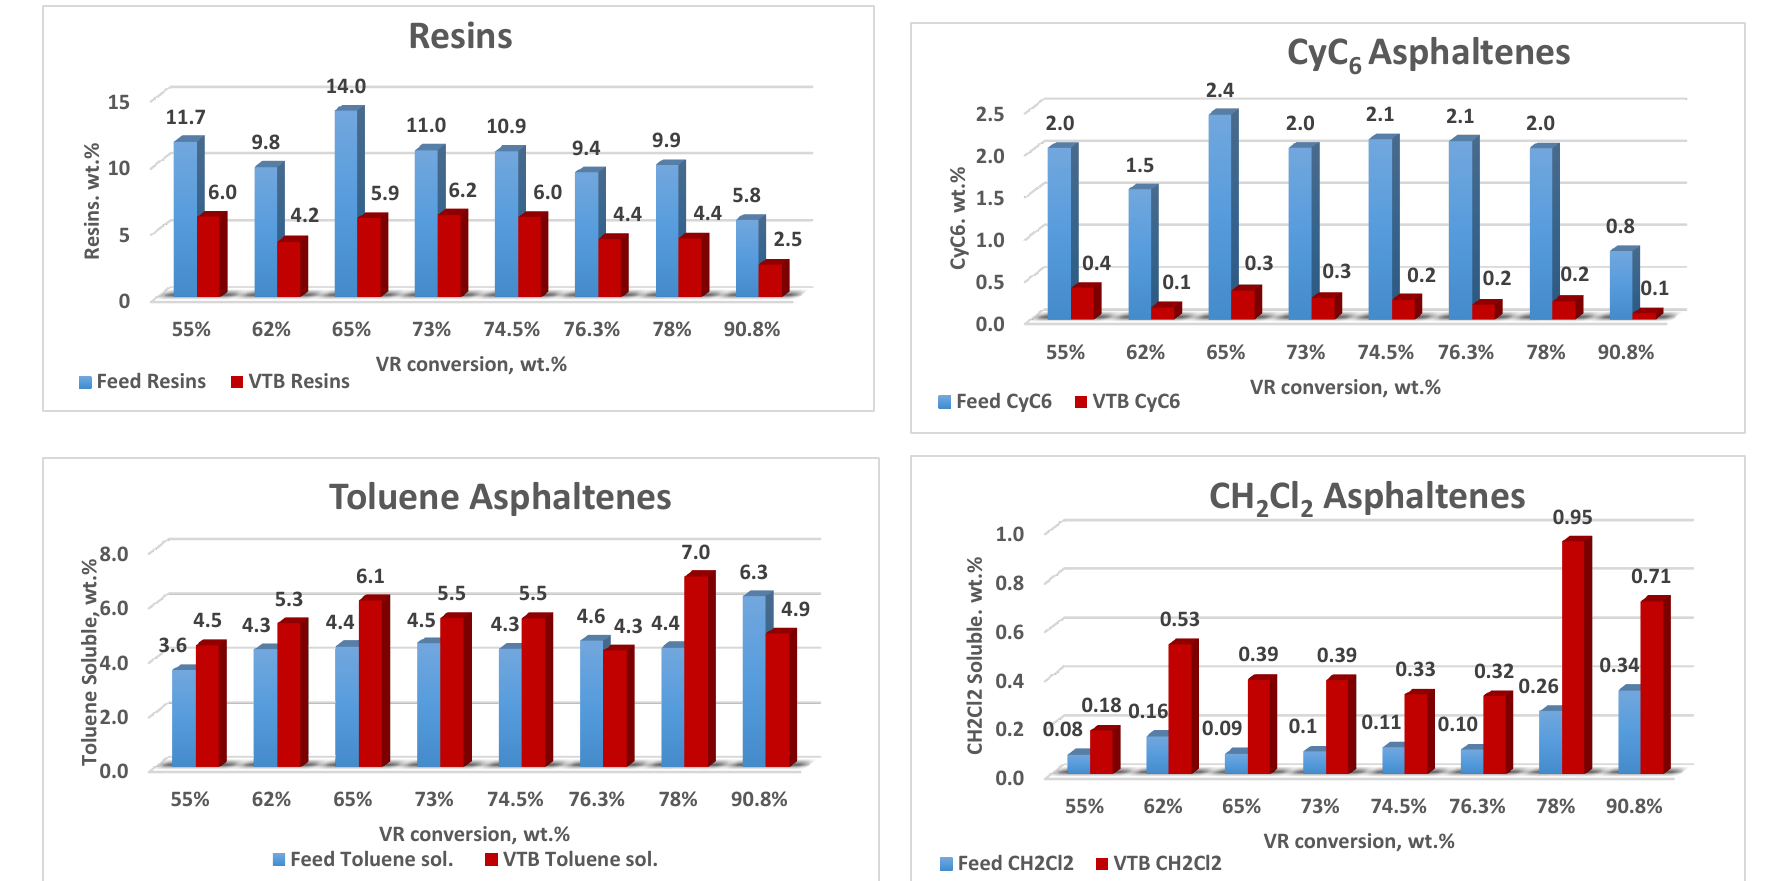
Figure 22. Variation of Resins and CyC 6 , Toluene, and CH 2 Cl 2 asphaltene content in the H-Oil VTBs with conversion alteration, juxtaposed against these SAR-AD components in the feeds.